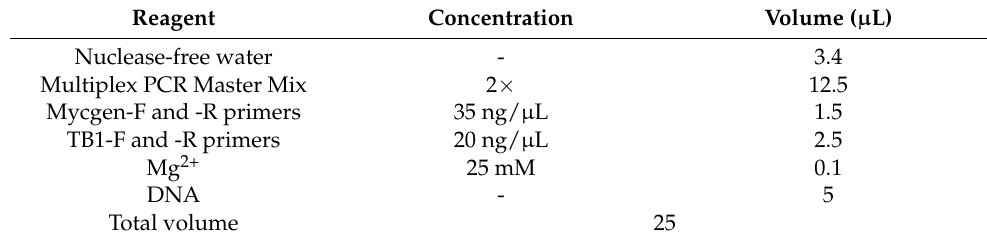
Table 2. Reaction components. Table 3. PCR